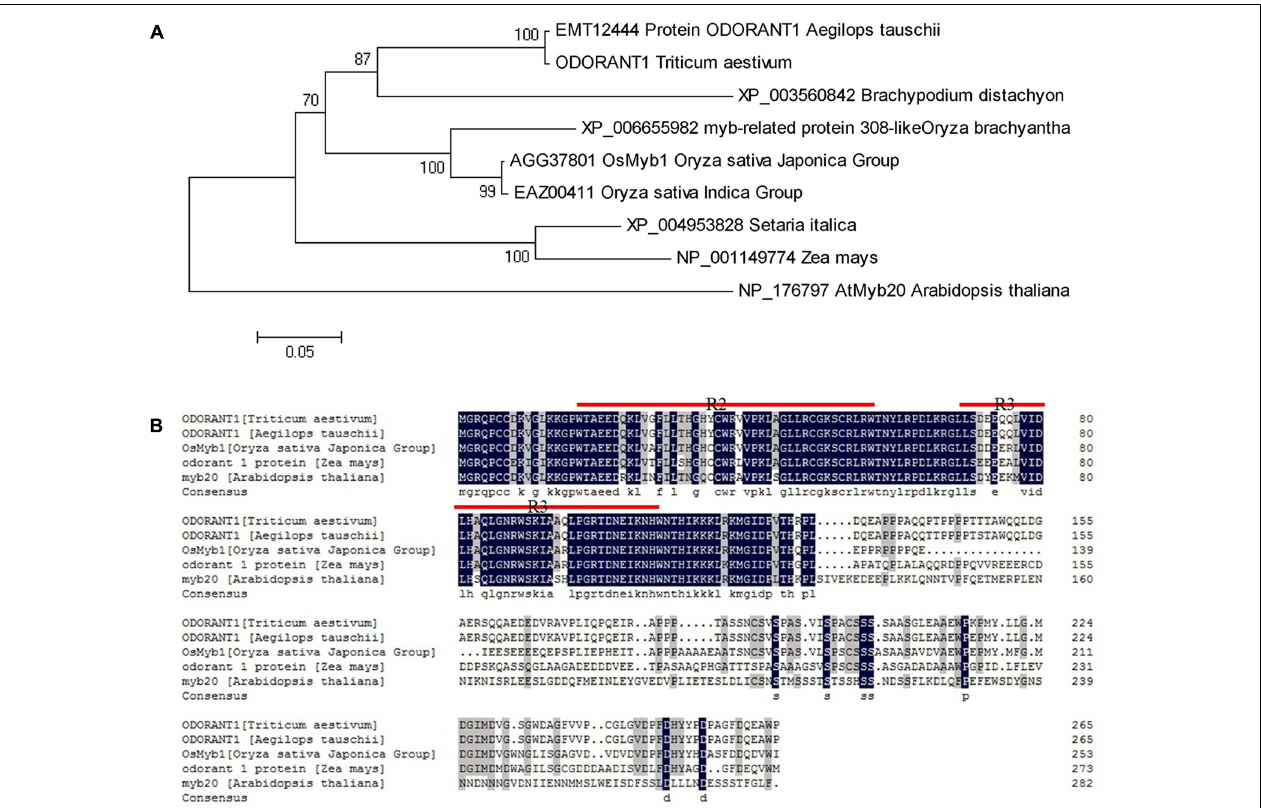
FIGURE 1 | Sequence and phylogenetic tree analysis of TaODORANT1. (A) Phylogenetic relationship of TaODORANT1 with its orthologs from other plant species. (B) Sequence alignment of TaODORANT1 and homologous proteins from other plant species. The black background represents identical amino acid residues in the aligned sequences. Red straight lines indicate the conserved domains of